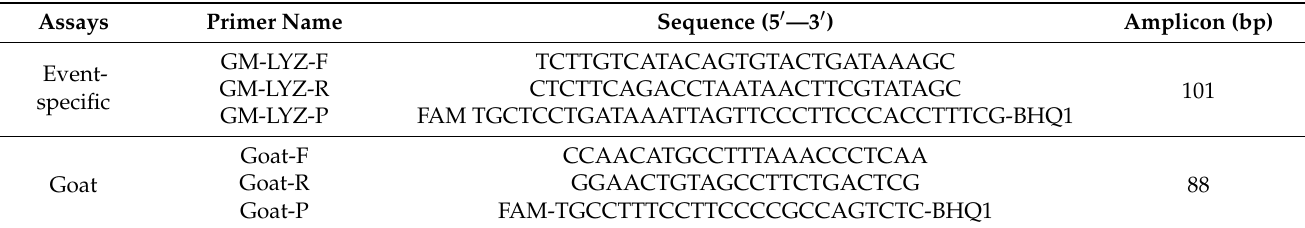
Table 1. Primers and probe for real-time polymerase chain reaction (PCR)